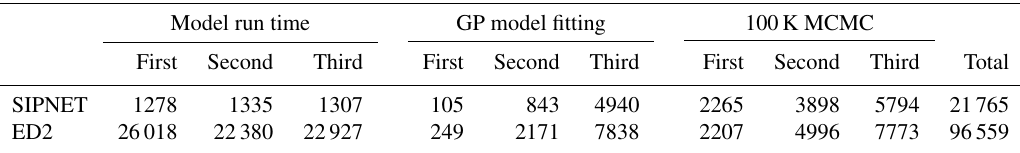
Figure 3. Emulator performance against synthetic data. The red vertical line represents the true parameter values that were used to create the synthetic dataset. Shaded distributions are the posteriors obtained after each emulator round. Dashed lines are the posteriors after a single emulator (all at once, AAO) round built with a total number of knots of all rounds (729 knots) instead of refining the emulator iteratively (first round 243, second round 486, third round 729). All priors were uniform for these parameters, except the multiplicative bias parameter. Table 1. Time elapsed (in seconds) for each step of the emulator calibrations. “Model run time” refers to the computation time for running the LHC model ensemble needed to construct the emulator. Sub-columns refer to the rounds of the emulator (first: 243, second: 486, third: 729 = 9 3 knots cumulatively for SIPNET; first: 334, second: 667, third: 1000 = 10 3 knots cumulatively for